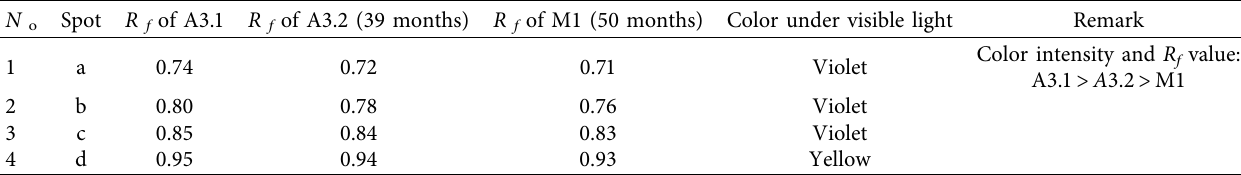
Table 2: HPTLC R f values of A3.1, A3.2, and M1 samples developed in solvent system B (from left to right in Figure 5).